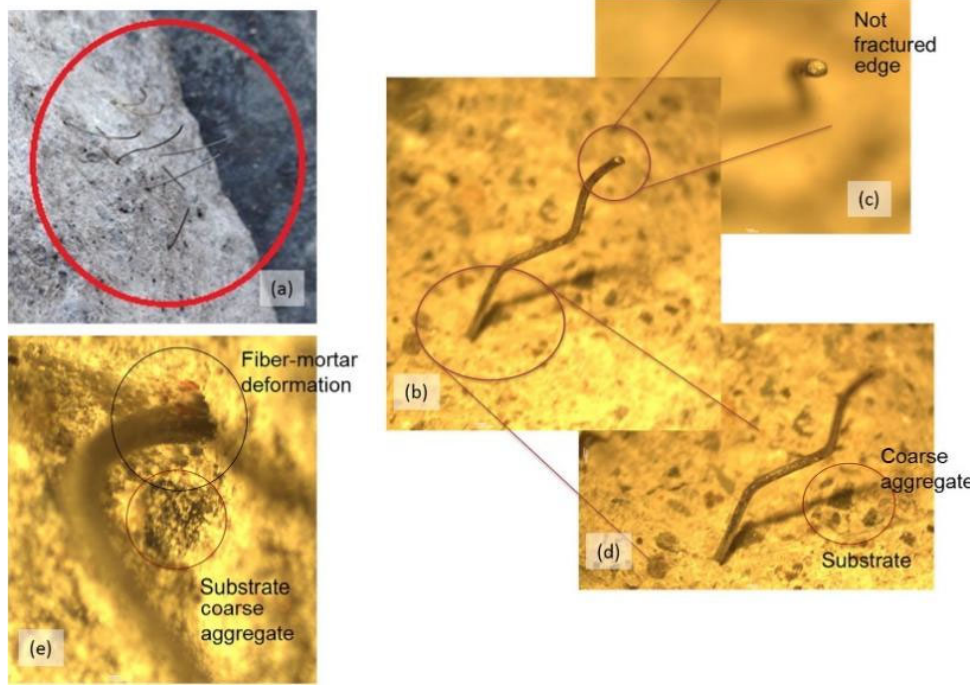
Figure 17. Fracture surface of a sandblasted substrate where steel fibers are bound to repair mortar after failure ( a ) and fiber-concrete details from optical microscope ( b – e ). [79]. (Adapted and reprinted with permission from ref. 79, © 2018, Construction and Building Materials .).